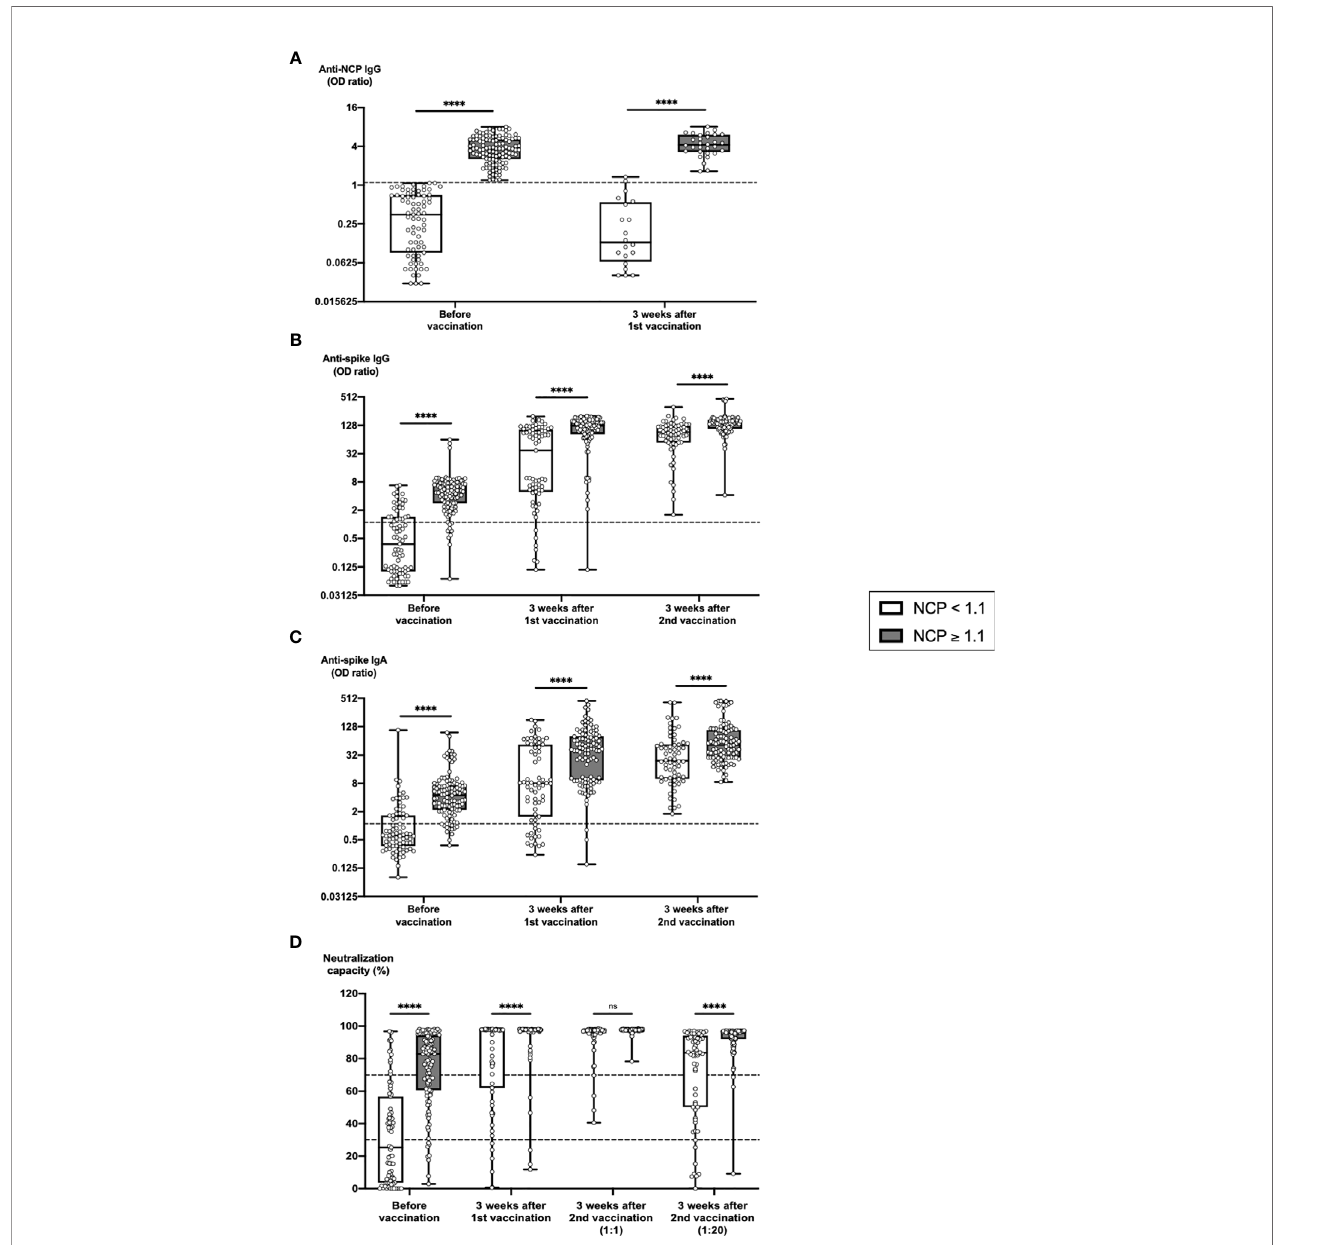
FIGURE 3 | Predictive value of pre-vaccination anti-NCP IgG titers on the development of humoral immune parameters after vaccination. Serum samples from 75 subjects with anti-NCP IgG OD ratios < 1.1 and from 112 subjects with anti-NCP IgG OD ratios ≥ 1.1 were collected before vaccination, 3 weeks after fi rst vaccination and 3 weeks after second vaccination with BNT162b2. Samples were analyzed for anti-spike IgG and IgA titers, anti-NCP IgG titers as well as for ACE2- RBD neutralization capacities. Box blots show (A) anti-NCP IgG titers, (B) anti-spike IgG titers, (C) anti-spike IgA titers and (D) median neutralization capacities at different time points as indicated. Dotted lines indicate cutoff values. To further differentiate high neutralization capacities 3 weeks after second vaccination, an additional analysis using an extra serum pre-dilution of 1:20 was performed (blot pair on the right side in panel D). Box central horizontal lines indicate medians, box borders represent IQR, whiskers indicate minima and maxima. Signi fi cance level was ****p < 0.00005. ACE2, angiotensin-converting enzyme 2; IQR, interquartile ranges; NCP, nucleocapsid; ns, not signi fi cant; OD, optical density; RBD, receptor-binding